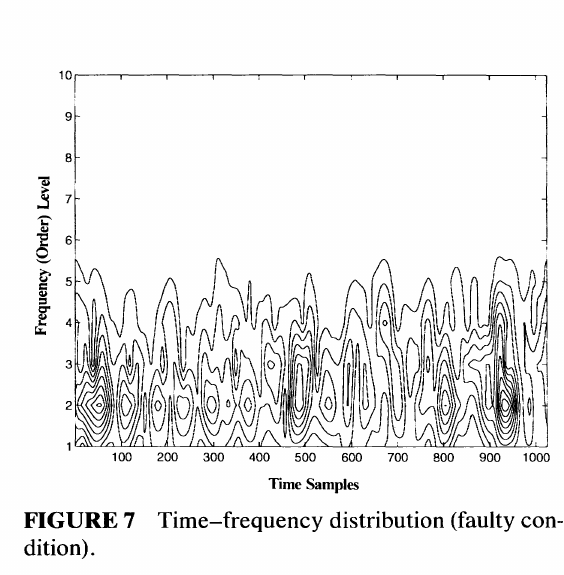
FIGURE 7 Time-frequency distribution (faulty con dition).